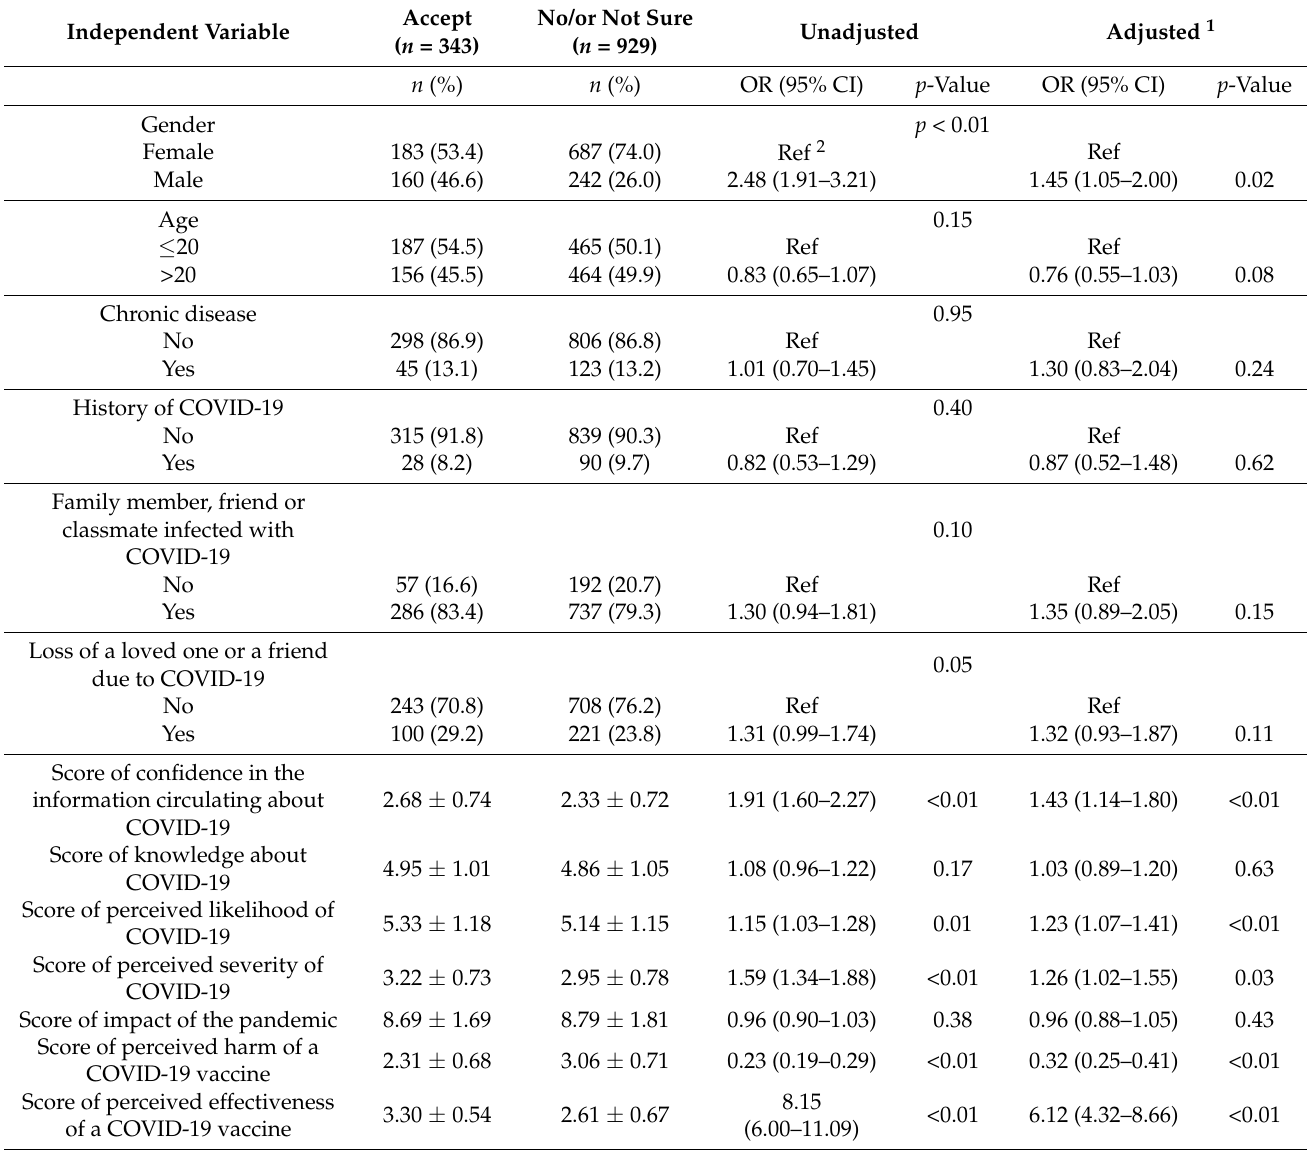
Table 2. Factors associated with COVID-19 vaccine acceptance ( n =